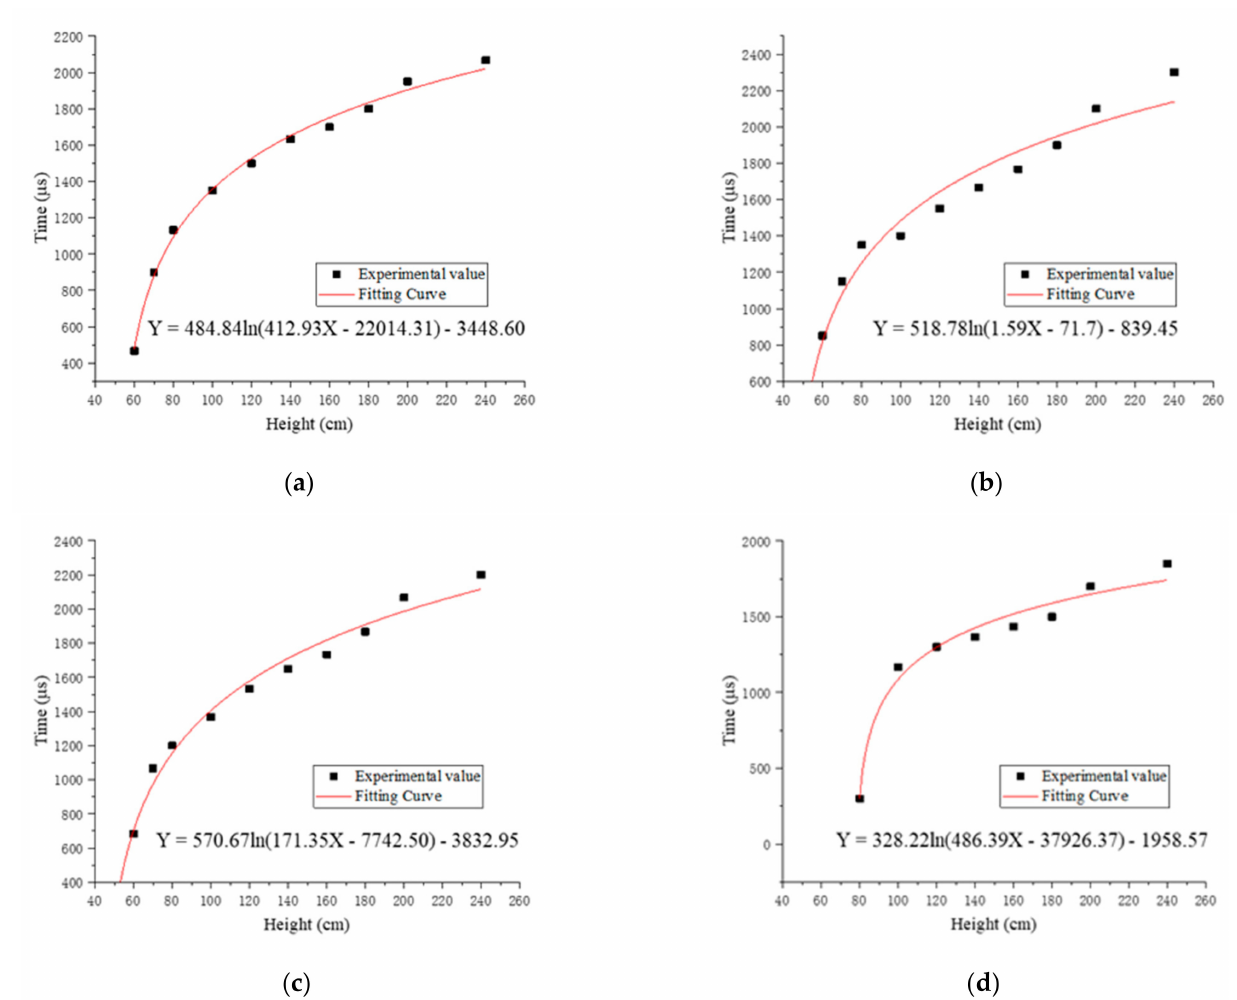
Figure 5. The fitting curves and functions of the relationship between the drop height and flame duration of four specimens: ( a ) fitting curve and function of #1; ( b ) fitting curve and function of #2; ( c ) fitting curve and function of #3; ( d ) fitting curve and function of